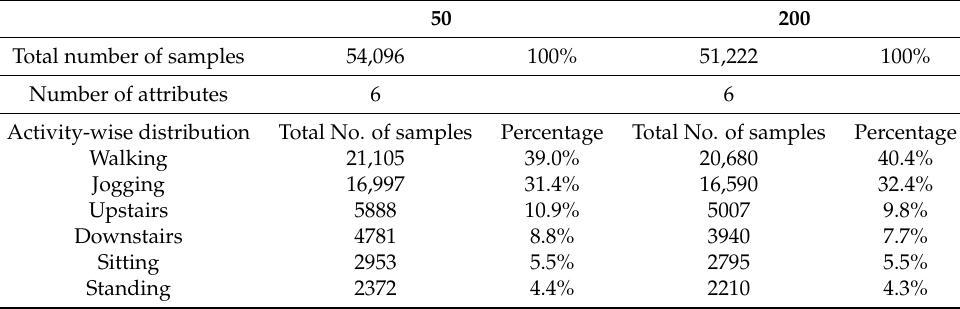
Table 4. Windowed WISDM dataset